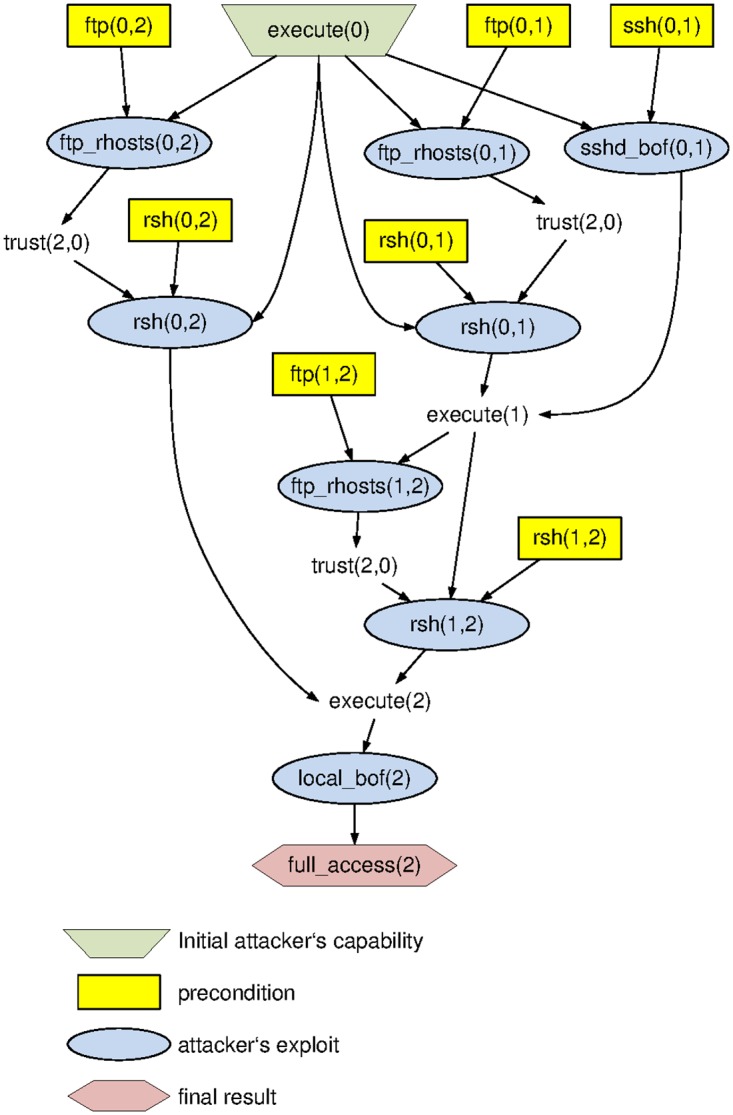
Example Attack Graph [38].